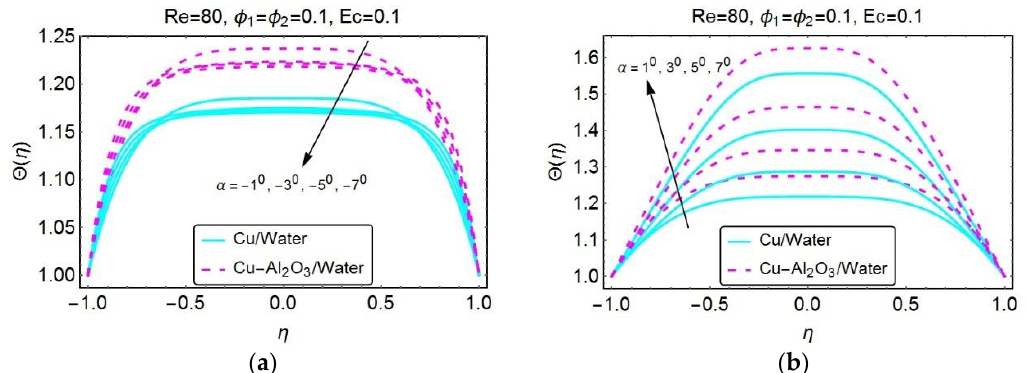
Figure 6. Stimulus of α on Θ ( η ) : ( a ) convergent case and ( b ) divergent channel.